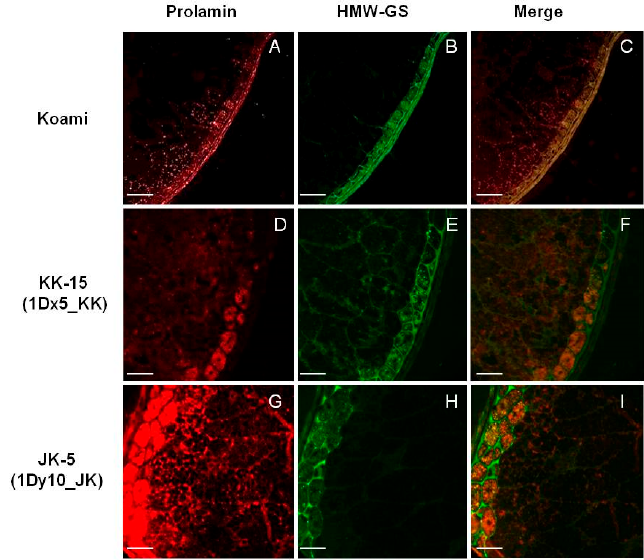
Figure 6. Immunofluorescence localization of prolamins and wheat HMW-GSs in wild-type rice seeds of Koami ( A – C ) and transgenic rice lines KK-15 overexpressing 1Dx5_KK ( D – F ) and JK-5 overexpressing 1Dy10_JK ( G – I ). Fluorescence images were generated using red anti-prolamin antibodies ( A , D , G ) and green anti-HMW-GSs antibodies ( B , E , H ); which were then merged ( C , F , I ). White Scale bar: 100 μ m.